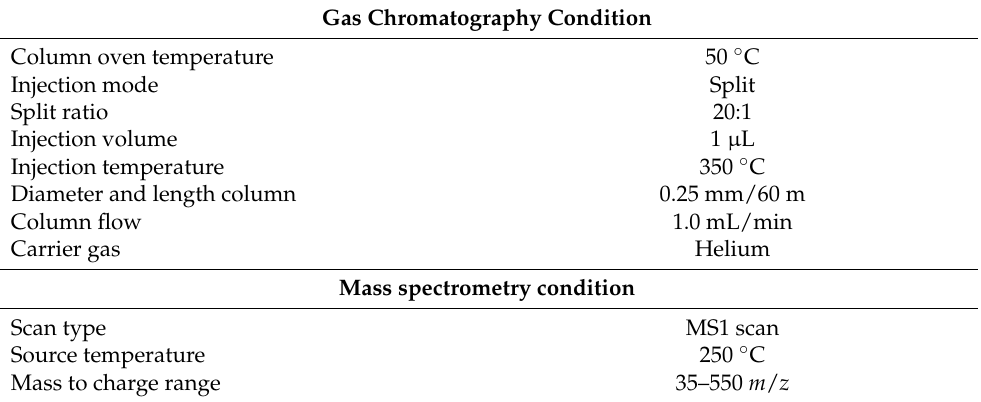
Table 1. The analytical conditions of the